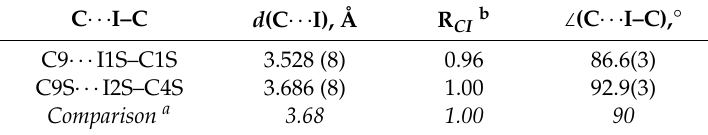
Figure 4. The lp(I) ··· π (C) interaction between ASZ and 1,4-FIB molecules in ASZ · 1.5( 1,4-FIB ). Figure 4. The lp(I)··· π (C) interaction between ASZ and 1,4-FIB molecules in ASZ ·1.5( 1,4-FIB ). Table 2. Parameters of the lp(I) ··· π (C) interactions in ASZ · 1.5( 1,4-FIB Table 2. Parameters of the lp(I)··· π (C) interactions in ASZ ·1.5( 1,4-FIB ).